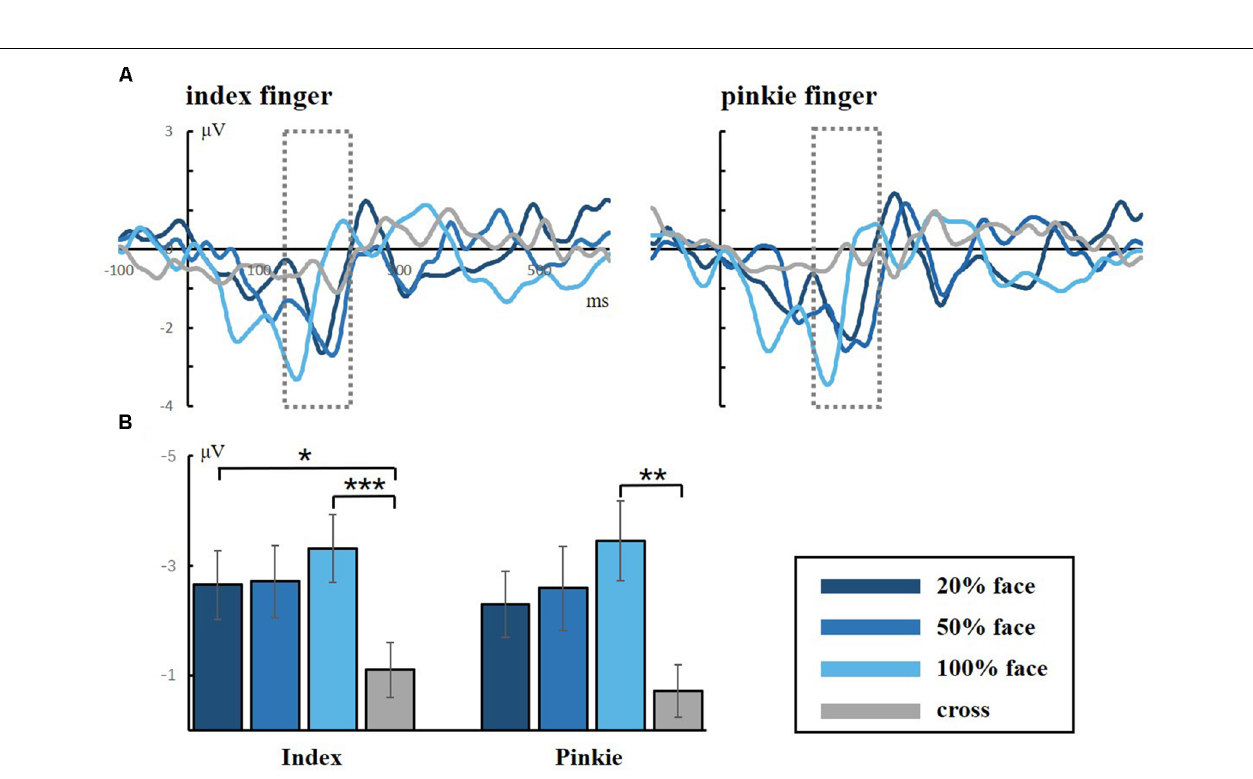
FIGURE 4 | (A) Grand averaged responses to facial stimuli for the index and little fingers in the occipital lobe (electrode CPZ). The gray dotted lines frame the ERP component of N170, which is a facial-specific component. (B) Statistical analysis for the N170 peak amplitude (* p < 0.05; ** p < 0.01; *** p < 0.001).